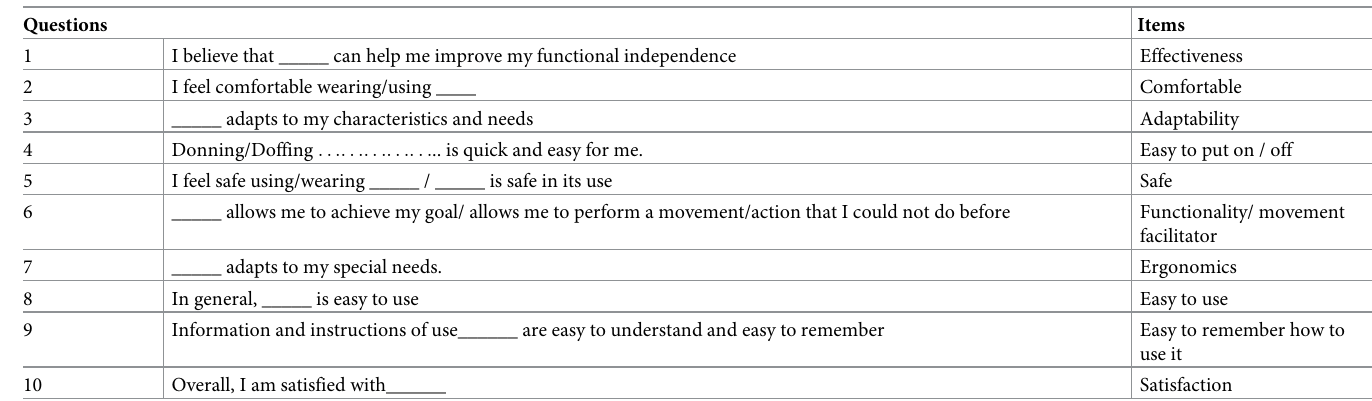
Table 4. Questions and the items that are involved in each question.